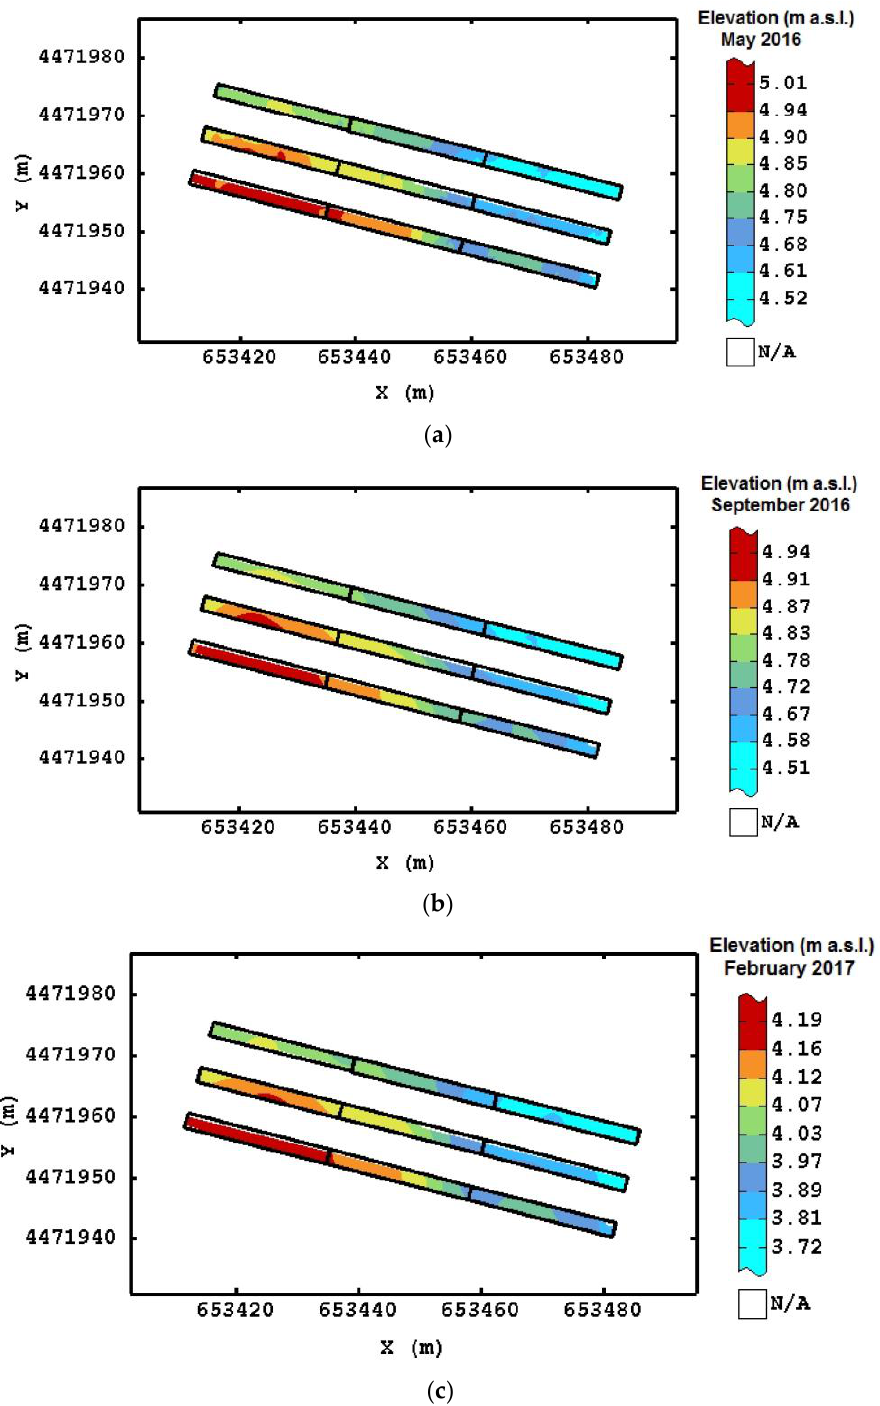
Figure 5. Spatial estimate of elevation in May 2016 ( a ); September 2016 ( b ) and February 2017 ( c ). Color scale uses iso-frequency classes.